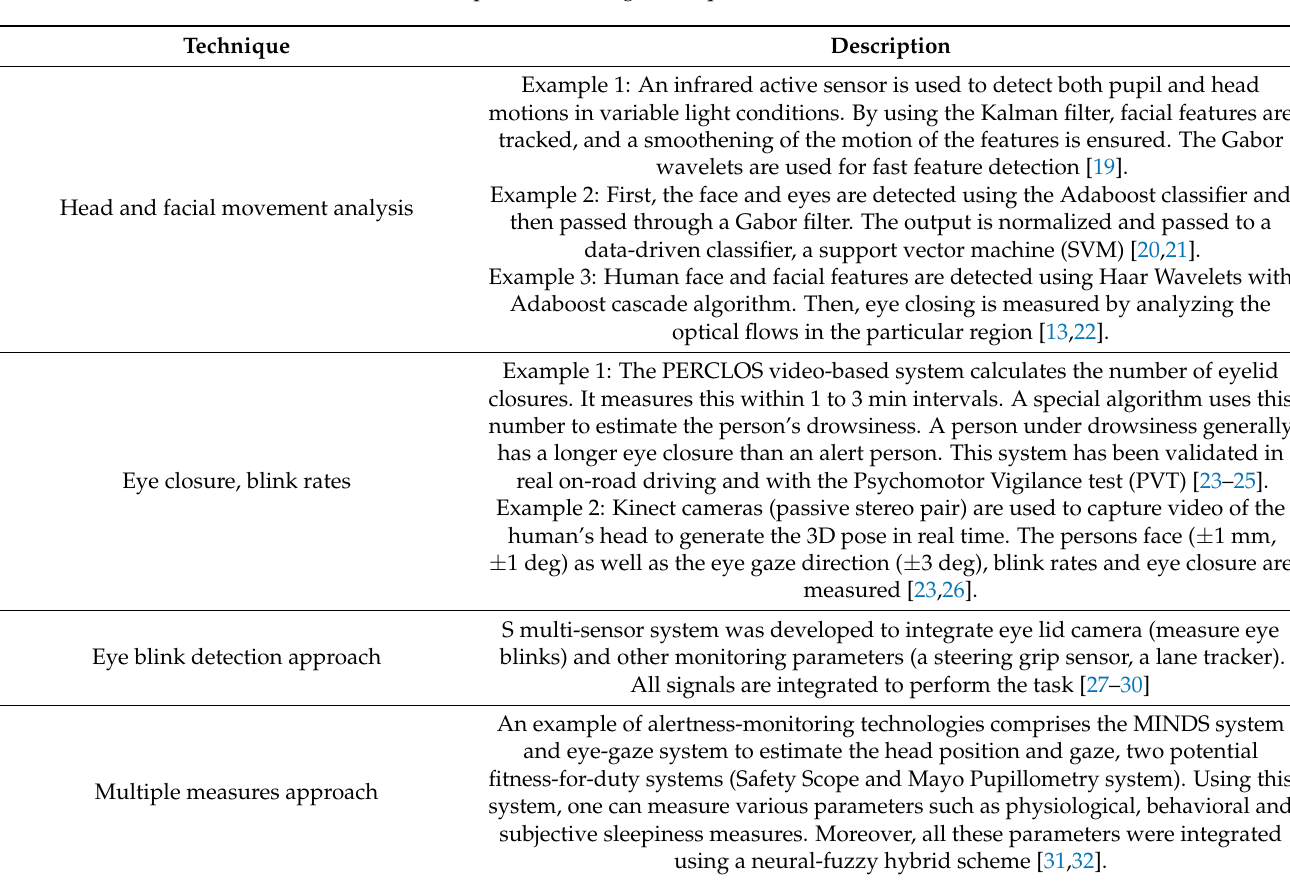
Table 1. Description of existing